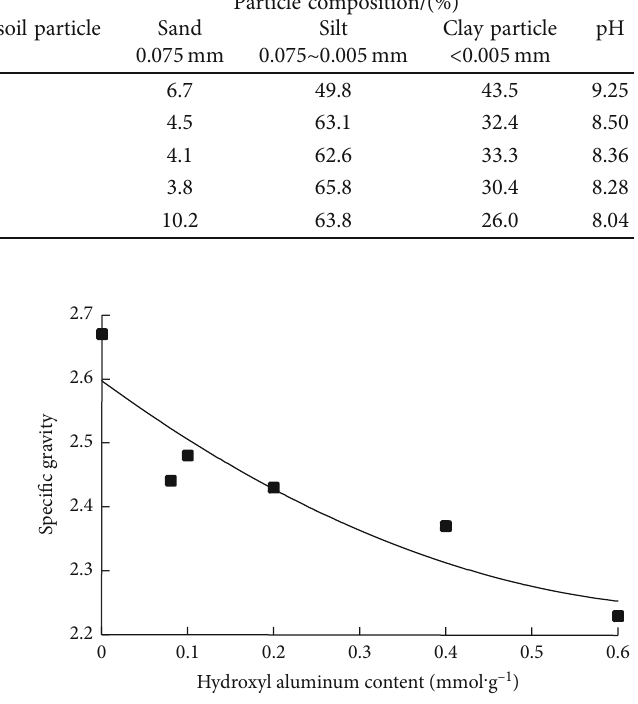
Figure 7: Variation of soil speci fi c gravity with hydroxyl aluminum content.